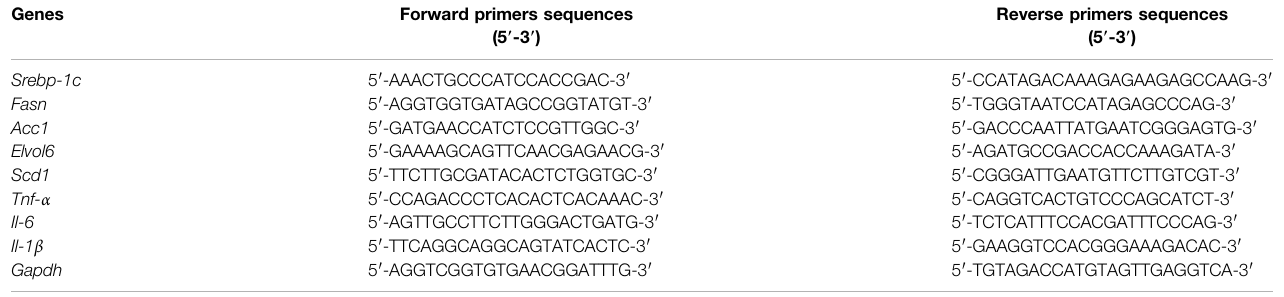
TABLE 1 | List of the sequences of qPCR primers used in this study. Genes